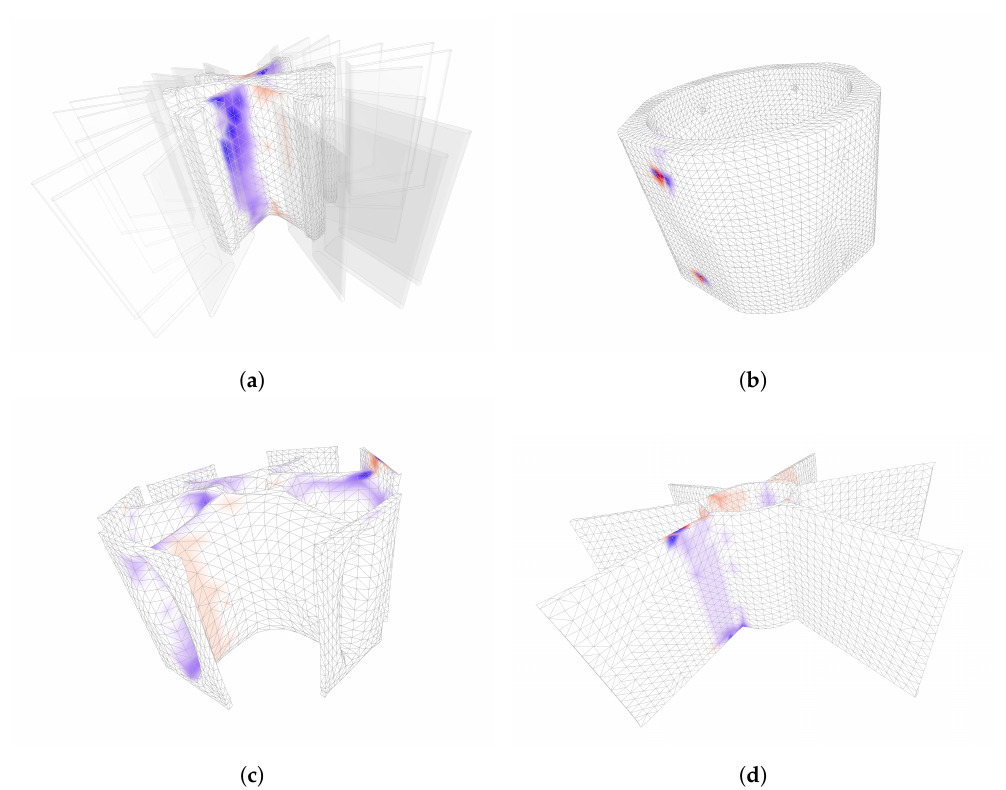
Figure 14. Stress plots for the nodes. The intensity of colours matches the intensity of stresses. ( a ) Stress concentrations in the GF Node. ( b ) Stress concentrations in the Mero ZK. ( c ) Stress concen- trations in the Starnode. ( d ) Stress concentrations in